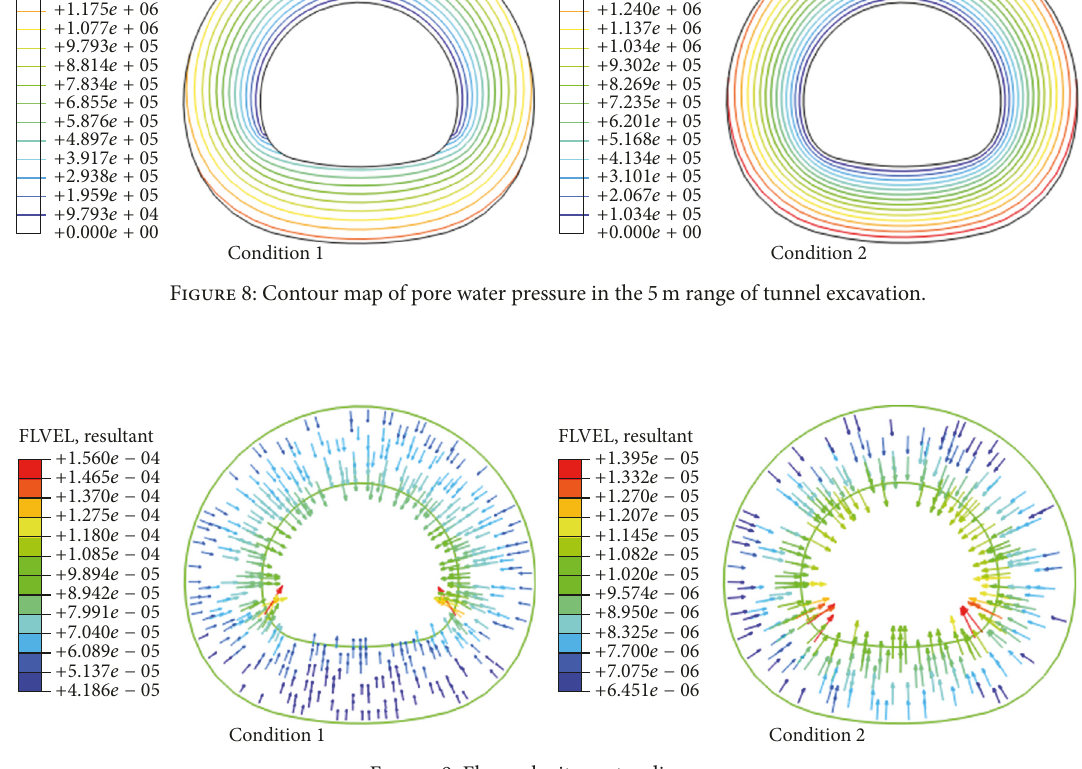
Figure 9: Flow velocity vector diagram.